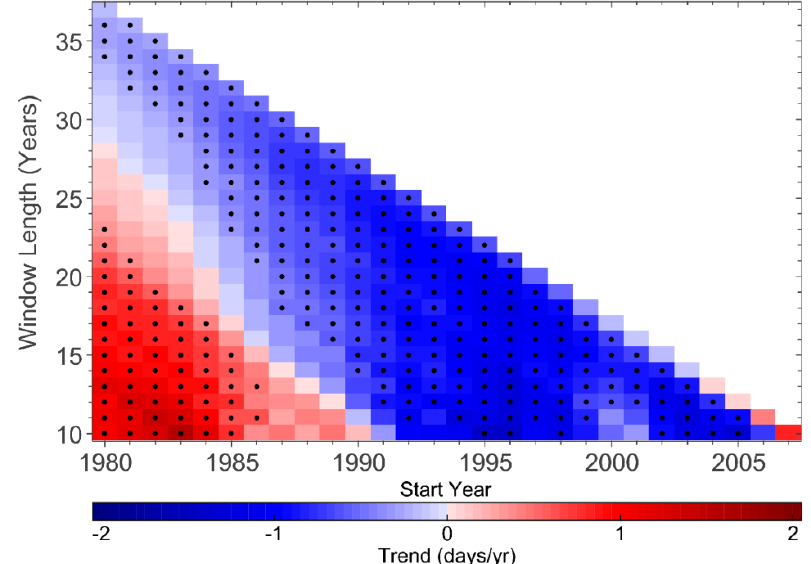
Figure 8. The running trend analysis for annual mean HDs at all stations starting from 1980 to 2007 and ending in 2016, with at least 10-year span required to calculate the trend. The x axis and y axis indicate the start year and the length of the time series to calculate trend, respectively. The color of rectangle represents the intensity of the trend, and those with black dots mean trends above 95% of significance level. Number of sites displaying statistically significant (at the 95% confidence level) increasing/decreasing